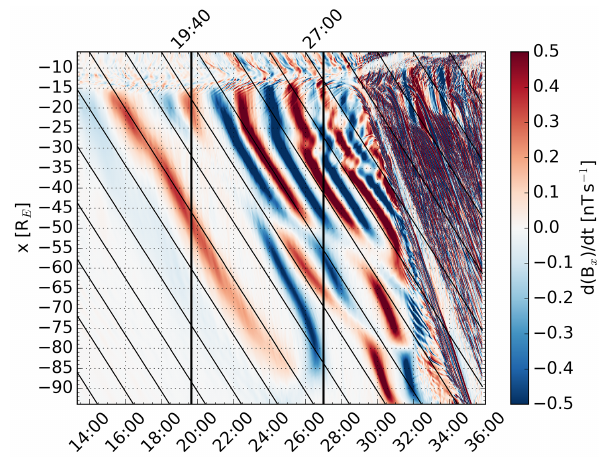
Figure 4. The same as Fig. 2 except that the color shows the north component of the ion bulk velocity ( V z ). The cyan curves indicate isocontours of pressure in the z direction ( P magnetic ,z + P thermal ,z ) with a thicker curve indicating higher pressure: 0 . 05, 0 . 1, and 0 . 2nPa. The magenta dots mark identified flapping half periods at x = − 30 R E , x = − 40 R E , and x = − 65 R E .